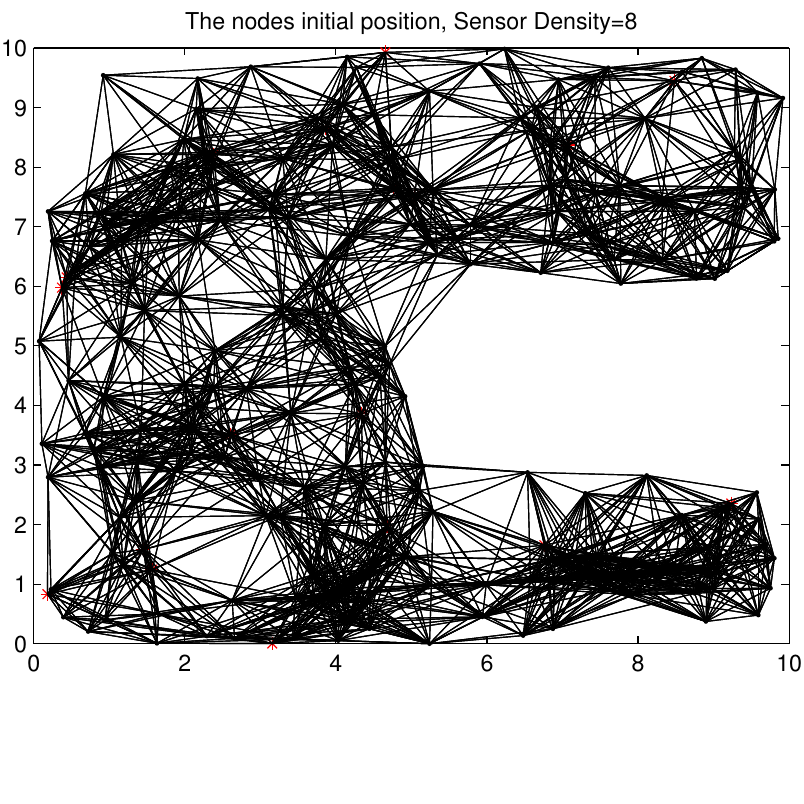
Figure 13. Initial node deployment in anisotropic C-shape